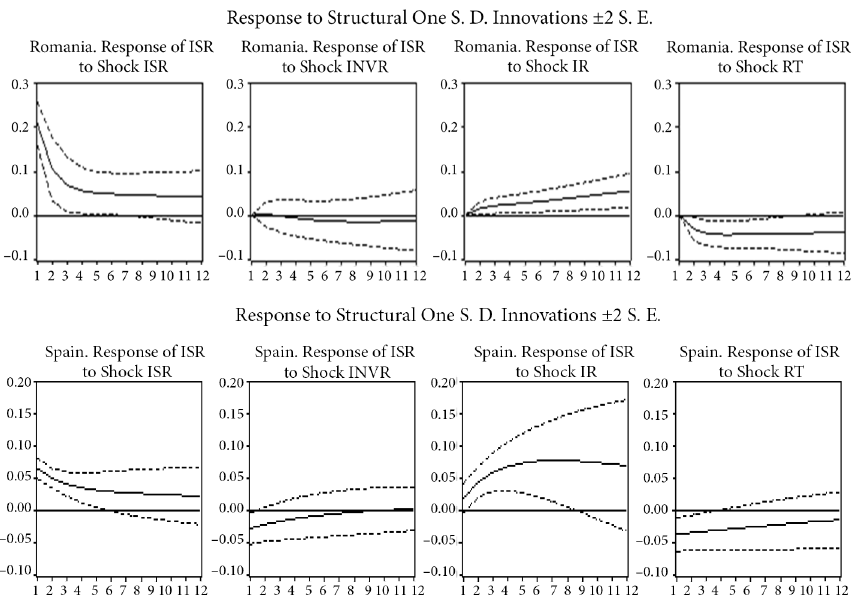
Figure 2. The impulse response functions